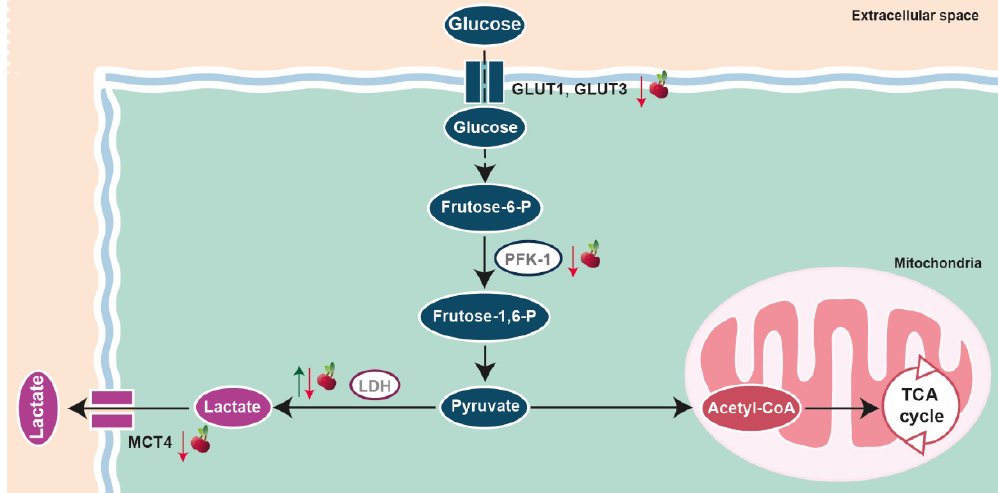
Figure 3. Sweet cherry actions in the regulation of glucose metabolism. Sweet cherry extract modulated glucose uptake in both neoplastic and non-neoplastic cancer cells, which was linked with the decreased expression of glucose transporters (GLUTs), GLUT1 and GLUT3. After entering the cell, glucose undergoes glycolysis with the production of pyruvate that can be converted to lactate by lactate dehydrogenase (LDH) or to acetyl-coenzyme A (Acetyl-CoA), which enters the tricarboxylic acid (TCA) cycle. In prostate cancer cells, the presence of sweet cherry extract also reduced lactate production, which was underpinned by the decreased activity of LDH and a reduced expression of the lactate exporter, monocarboxylate transporter (MCT) 4. In addition, sweet cherry extract downregulated phosphofructokinase-1 (PFK-1) expression in non-neoplastic cells, whereas increasing LDH activity. Green and red arrows mean up- and down-regulation of expression and/or activity, respectively.